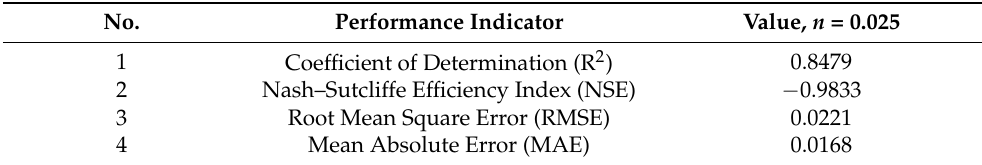
Table 3. Performance indicators of the validated Manning’s